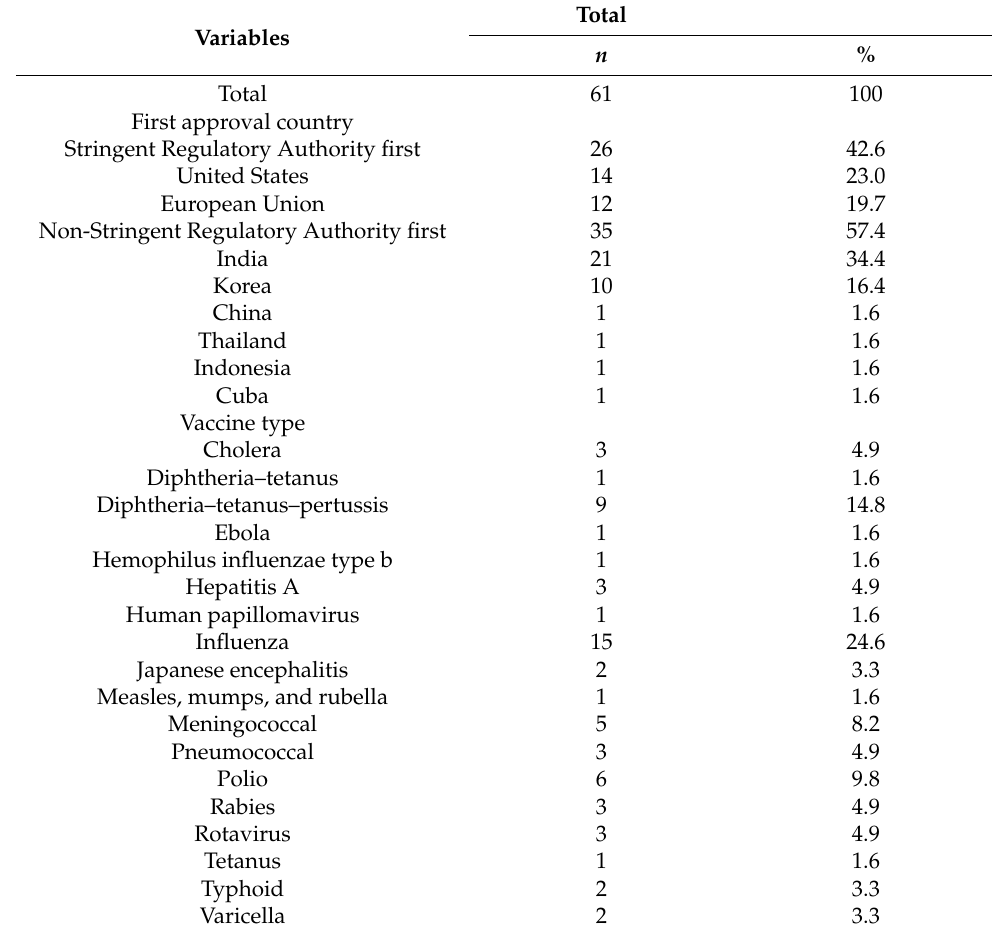
Table 2. Characteristics of WHO-prequalified vaccines between 2010 and 2019 ( n = 61).